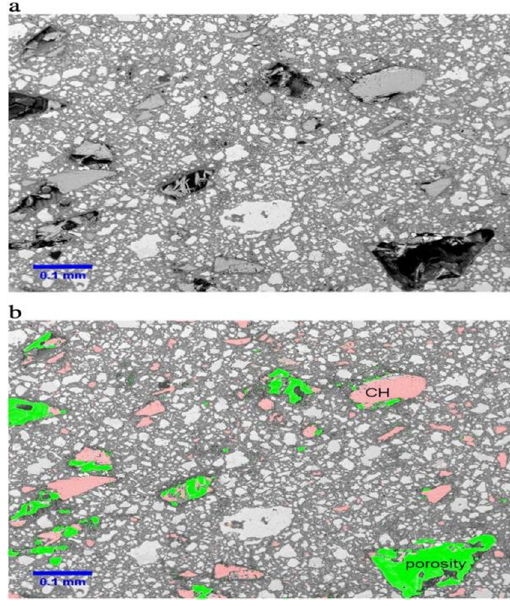
Figure 7: SEM micrograph of SAP paste ( a ) Original image ( b ) modi fi ed image with overlaid clustered porosity and Portlandites [ 2 ]